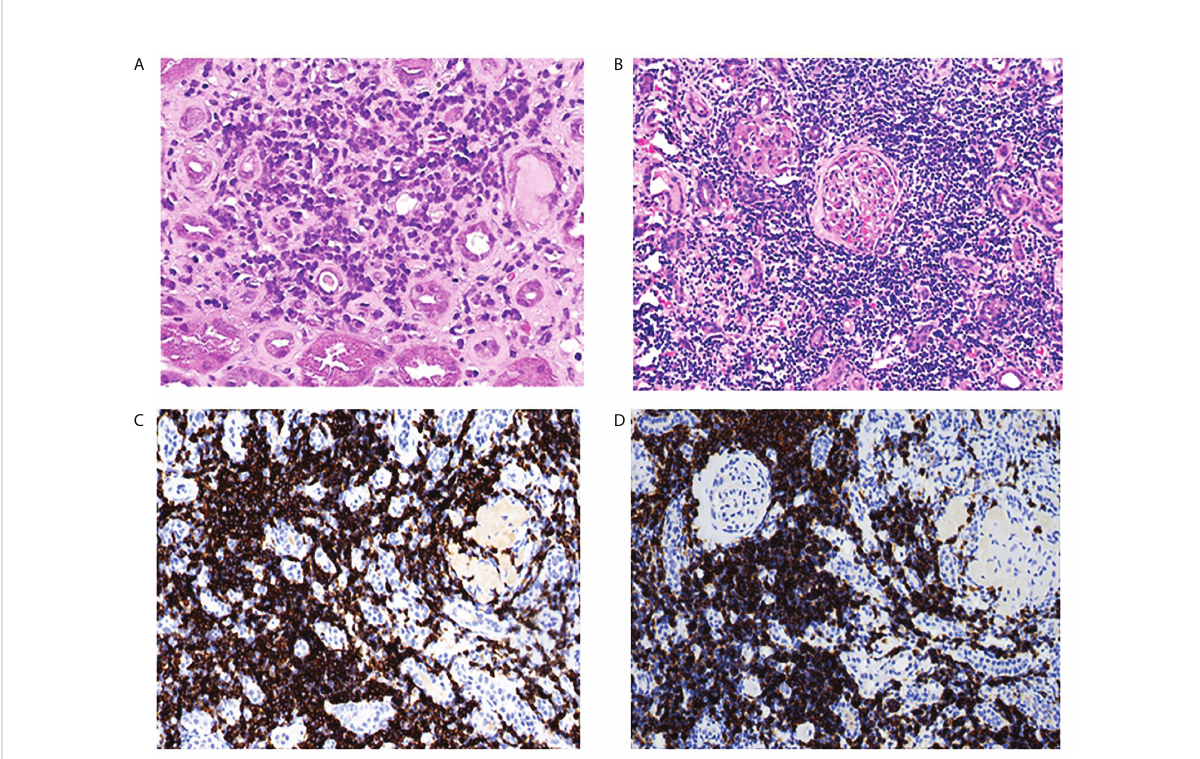
FIGURE 2 Kidney pathological fi nding. lymphocytic in fi ltration of the renal interstitium. (A) scattered atypical cells visible in the interstitium in one patient with LPL (PAS,original magni fi cation×400). (B) diffuse and massive in fl ammatory cell in fi ltration in the interstitium in a patient with CLL (hematoxylin and eosin staining, original magni fi cation×400), the in fi ltrating cells were positive for CD20 (C) and CD23 (D) by immunohistochemistry analysis (original magni fi